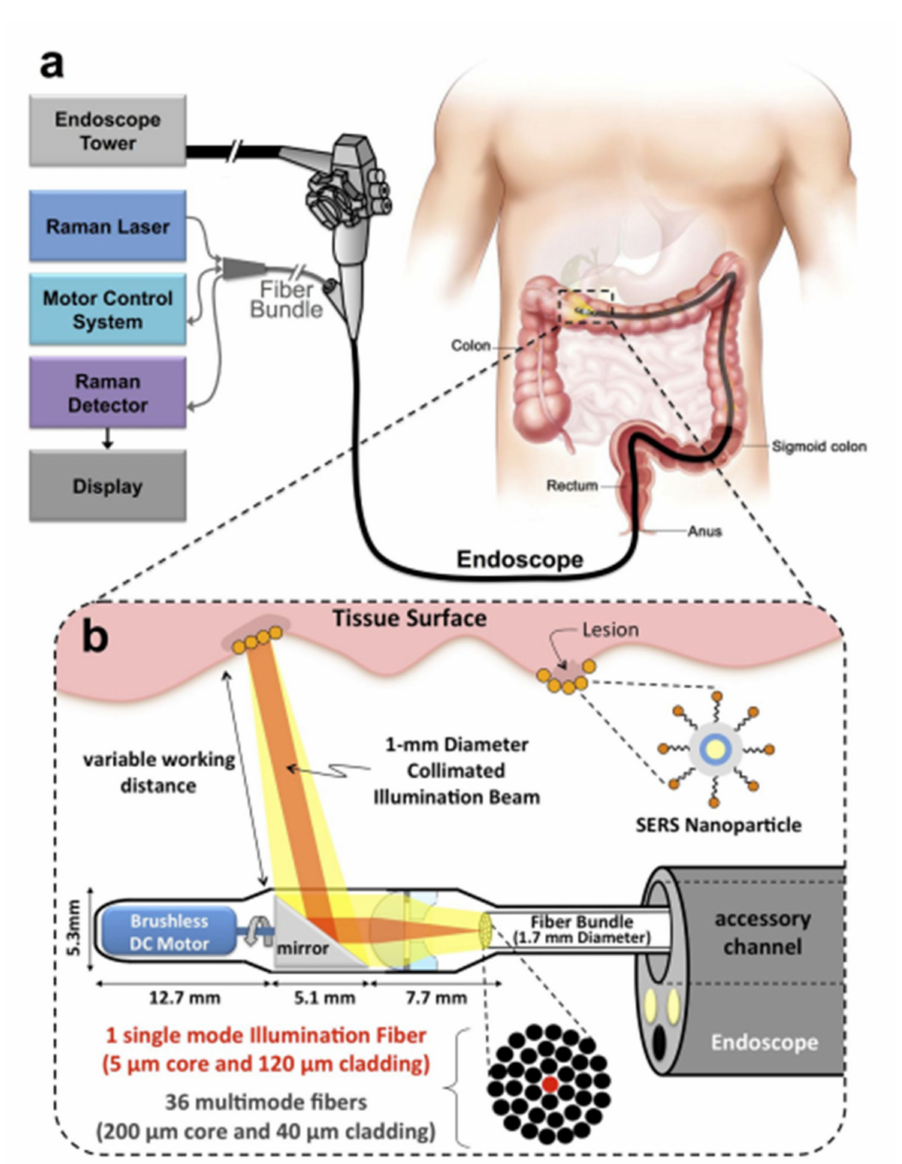
Figure 3. Schematic representation of a Raman system with SERS fiber-optic probe based Raman system which can perform white light endoscopy. ( a ) The design allows the Raman imaging system to get adapted on a clinical endoscope and scan the lumen as the endoscope is being retracted in the GI tract. ( b ) An expanded schematic illustration of the distal end of the device. The collimated beam can be swept by a brushless DC motor and its focus can be adjusted by a system of plano- convex and plano-concave lenses [79], https://doi.org/10.1371/journal.pone.0123185, access on 10 January